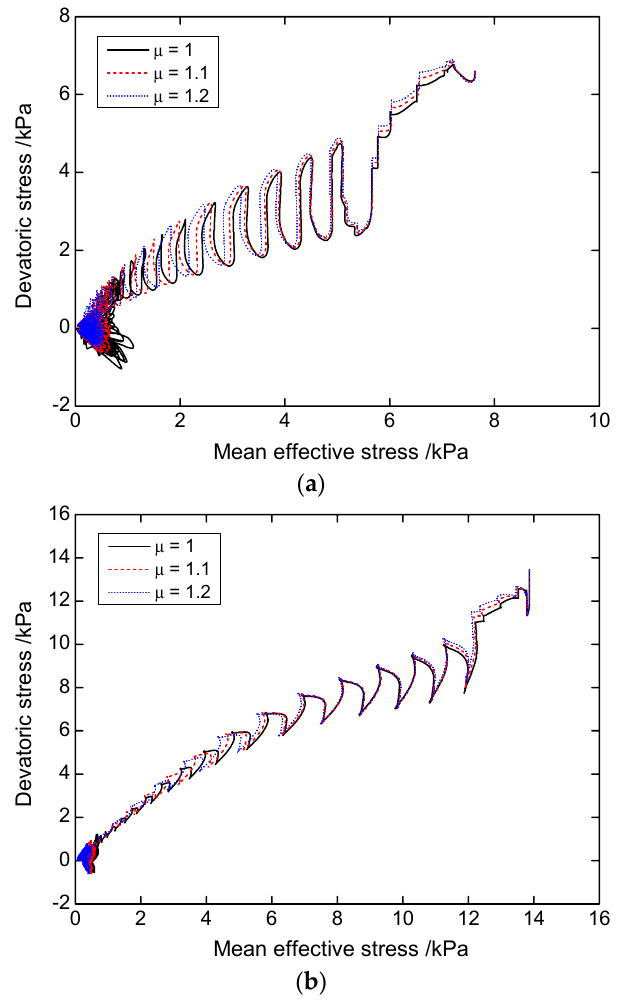
Figure 7. Stress path in mean effective stress-deviatoric stress plane: ( a ) point A; ( b ) point B.